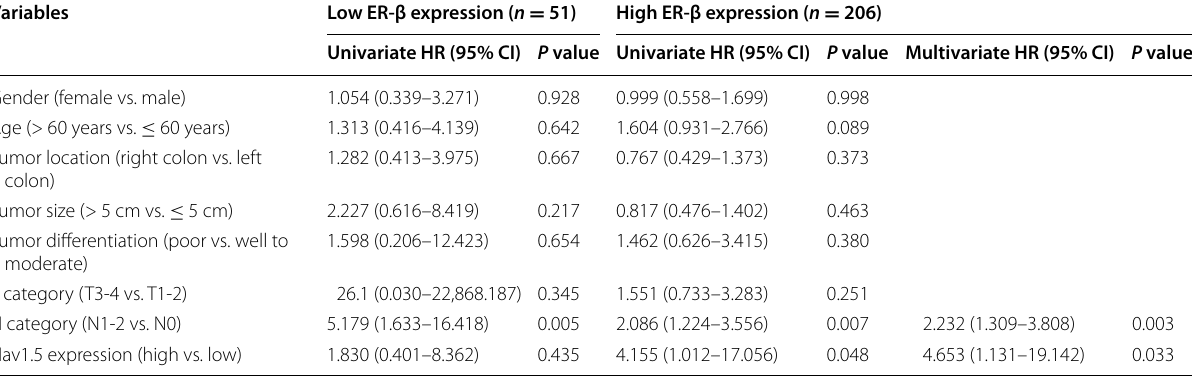
Table 3 Univariate and multivariate Cox regression analyses of prognostic factors for 5-year disease-free survival in patients with high and low ER-β